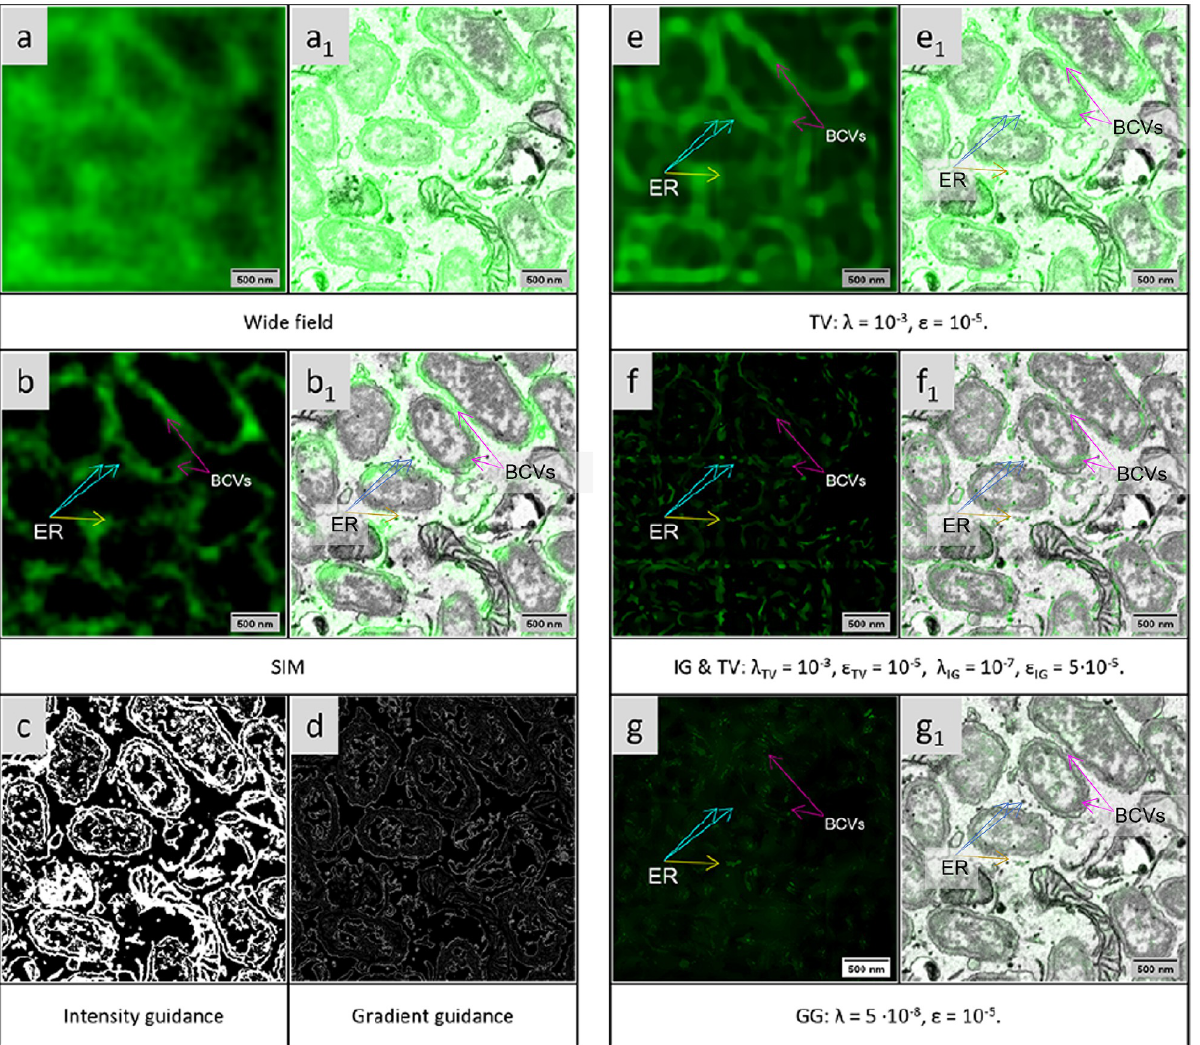
Fig 7. CLEM images of GFP-labeled endoplasmic reticulum (ER) and Brucella -containing vacuoles. a) The wide-field fluorescence image. b) The SIM restoration image. c) The intensity guidance map is obtained via Weka segmentation. d) The gradient guidance is generated by calculating the absolute spatial gradient of the intensity guidance map. e) The restored images of the modified total variation deconvolution (brightness -20%, contrast +40%). f) The restoration of the combined TV & IG deconvolution from the wide-field fluorescence microscopy image (brightness +40%, contrast -40%). g) The restored images of the gradient-guided deconvolution (brightness +60%). a 1 ), b 1 ), e 1 ), f 1 ) g 1 ): The overlay of the CLEM image. Labeled membrane structures outside the bacteria are identified as Brucella -containing vacuoles (BCVs) and labeled membrane structures inside the bacteria as ER.